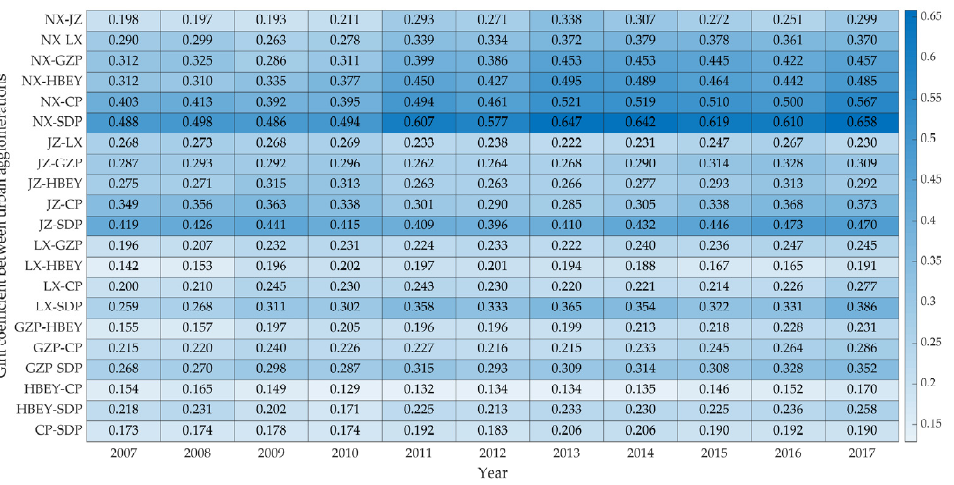
Figure 7. Changes in CEI differences between urban agglomerations in the YRB from 2007 to 2017.